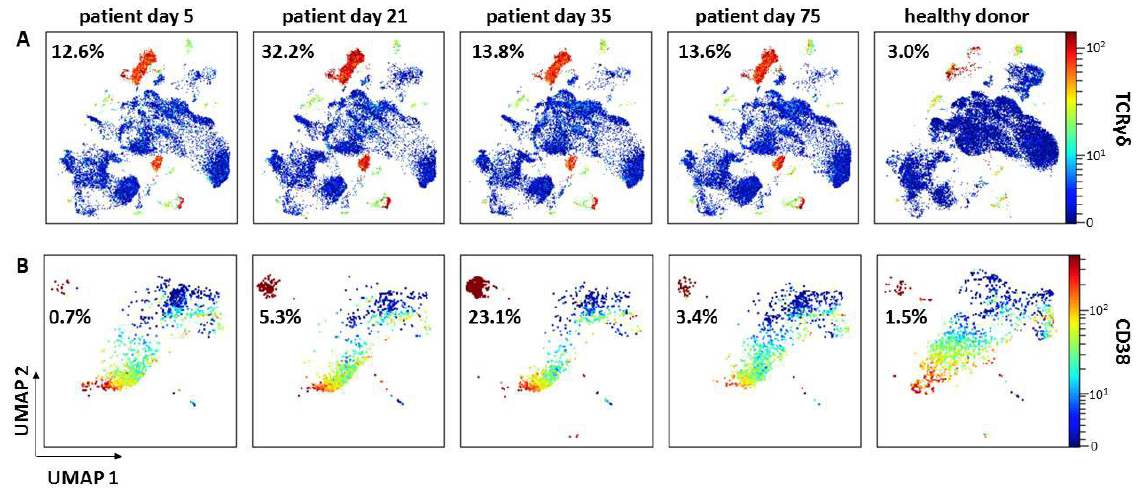
Figure 4. Uniform Manifold Approximation and Projection for Dimension Reduction (UMAP) of pre-gated CD3 + T cells ( A ) and B cells ( B ) from the patient’s blood sample on days 5, 21, 35, and 75 in comparison to a representative healthy donor (HD). The expression of TCR γδ and CD38 indicates TCR γδ + T cells ( A ) and plasmablasts ( B ), respectively. Highest frequency of TCR γδ + T cells was observed at day 21 and for plasmablasts at day 35, respectively (HD ( n = 20): %TCR γδ + T cells = 3.1 ± 2.8; %PB =